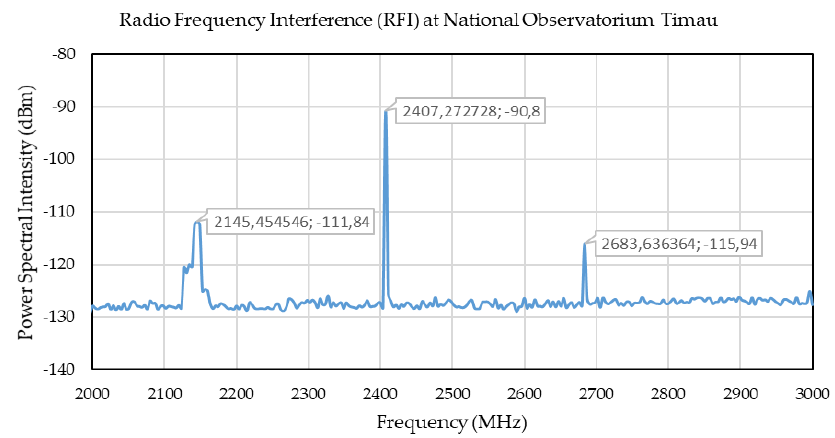
Figure 8. Results of radio frequency survey at low frequencies between 1400 and 2000 MHz.